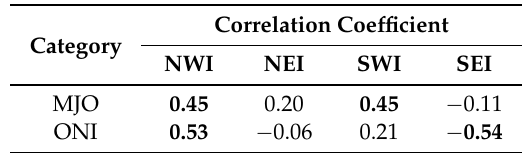
Table 3. Correlation coefficients of the variation of GPI anomalies averaged for each region ( i.e. , northwestern part (NWI), northeastern part (NEI), southwestern part (SWI), and southeastern (SEI) part of the Indian Ocean to the variation of the number of days of active MJO and averaged Oceanic Niño Index (ONI) during October–December 2011 (OND). Bold characters mean statistically significant at the 95% level.